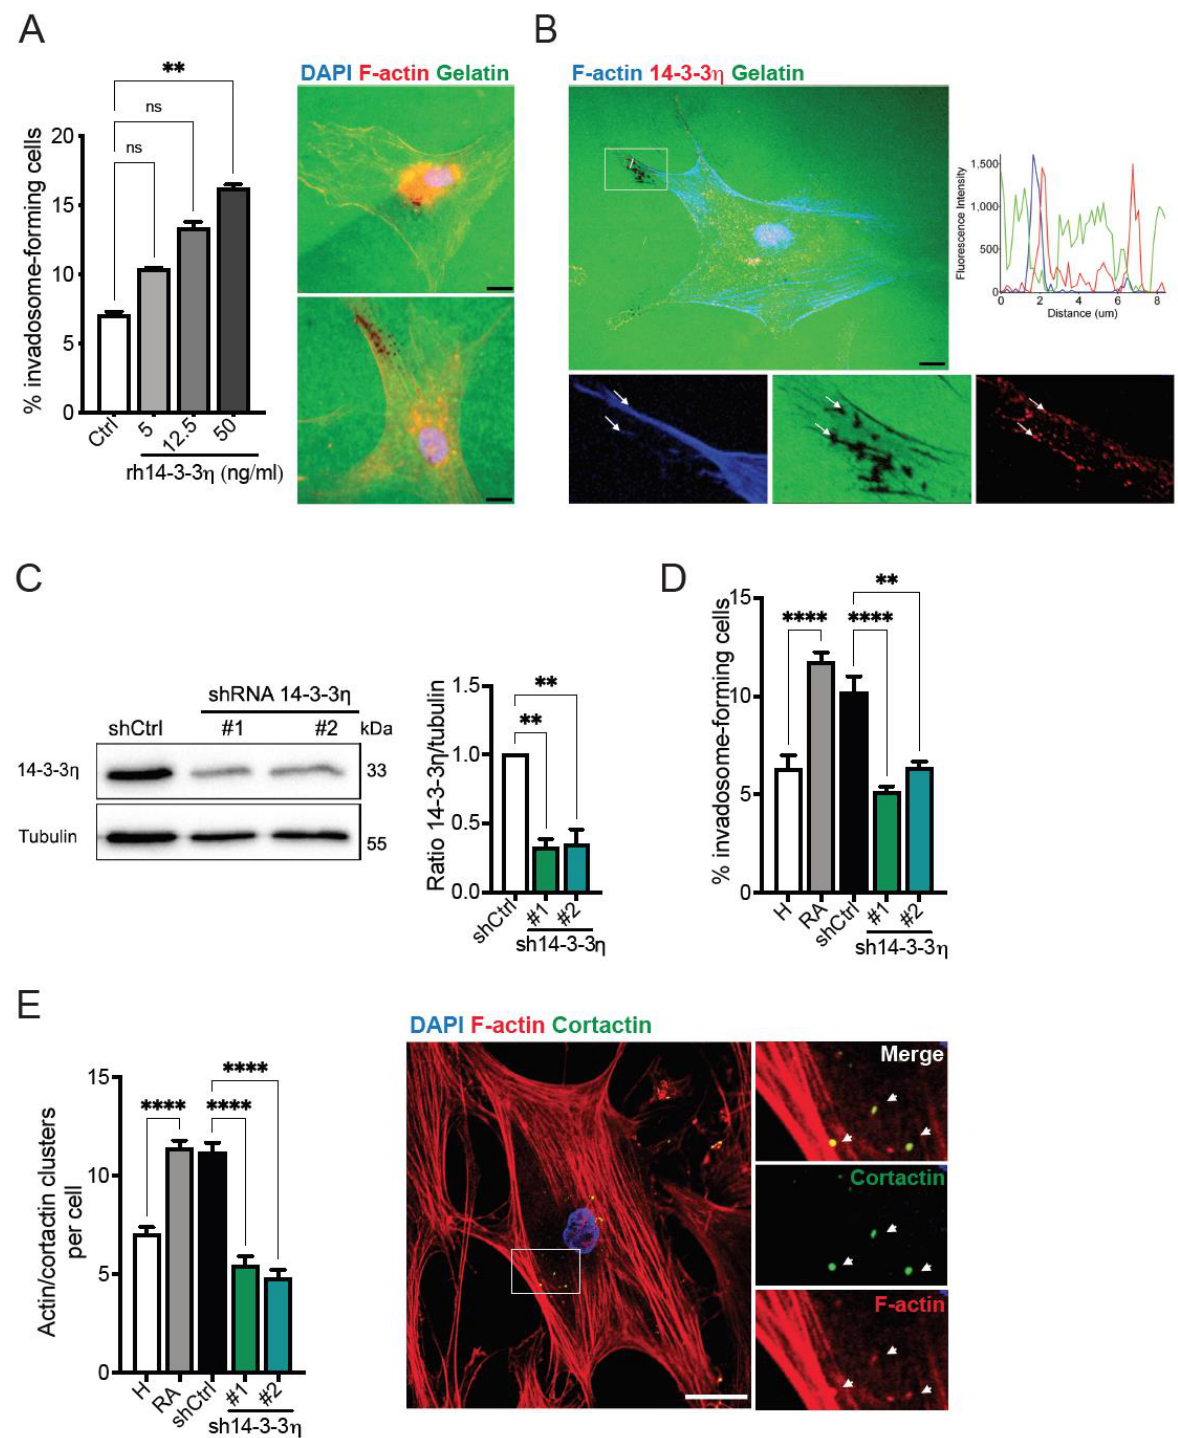
Figure 2. Regulation of invadosome formation by 14-3-3η. ( A ) H FLS were plated on Oregon green 488 -conjugated gelatin coverslips for 48 h in the presence or absence of human recombinant 14-3-3η protein (rh14-3-3η) used at the indicated concentrations (n = 4). The associated micrographs show representative invadosome formation (stained for F-actin (red), gelatin (green), and nuclei (DAPI, blue)) of untreated (ctrl) and rh14-3-3η (50 ng/mL) treated cells. Scale bar = 20 µm. ( B ) Rep-